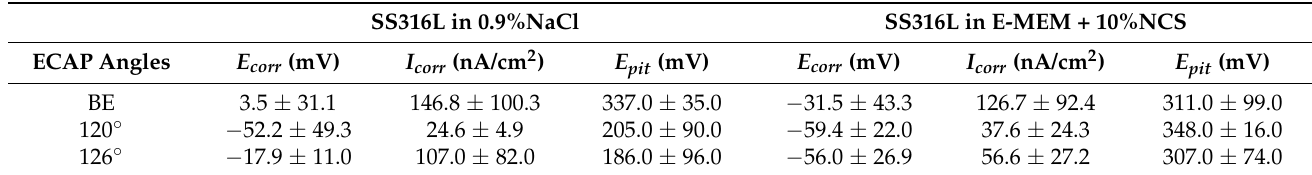
Table 1. Corrosion parameters of 316L SS before and after ECAP.